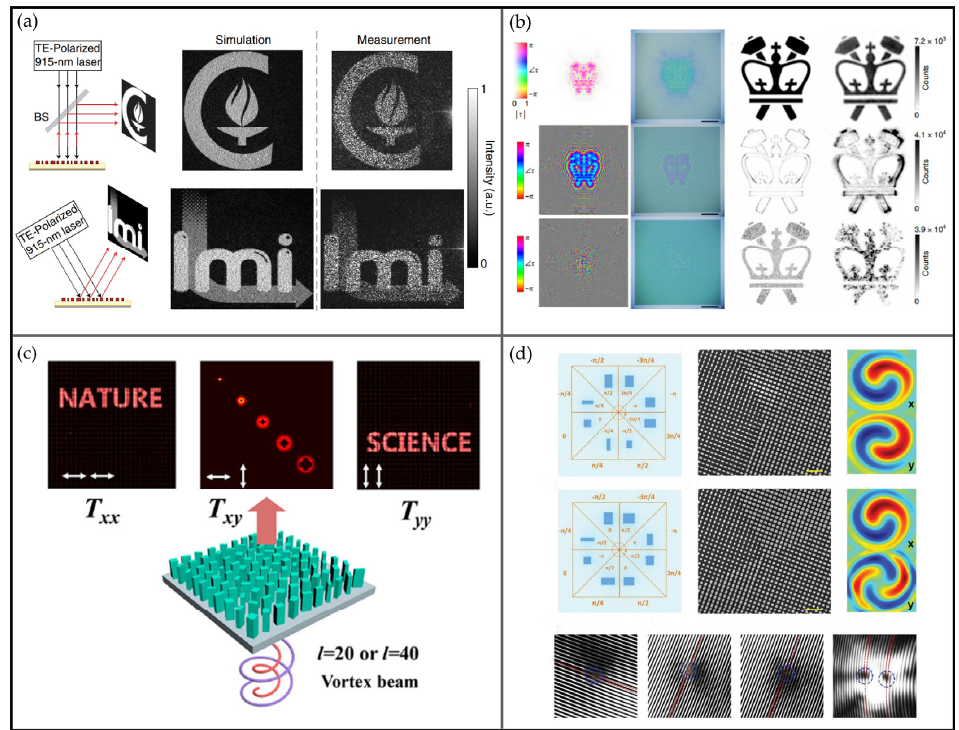
Figure 4. ( a ) The angle-multiplexed hologram exhibits different holograms under normal and 30° incident angles with TE polarization. Reprinted from [73]. CC BY 4.0; ( b ) Si metasurface realizes the multiplexing of amplitude and phase, shows holograms, and compares them with phase mod- ulation only, Reprinted from [74]. CC BY 4.0; ( c ) the OAM multiplexing at different polarization channels Si metasurface demonstrates several holographic encryption. Reprinted from [75]. Copy- right 2020 American Chemical Society; ( d ) the schematic diagram of Si polarization multiplexing metasurface achieves a vortex converter, which transforms a Gaussian beam into a vortex beam with helical wavefront and shows experimental results of different OAM and Gaussian beams interference. Reprinted from [76], Copyright 2022 Wiley-VCH GmbH. It is worth mentioning that, although the above-mentioned metasurfaces can achieve various types of multitasking, but the full dimensional control of light (i.e., the independ- ent, simultaneous, and complete control of phase, polarization, amplitude) has rarely been reported, we believe that designing such full modulation metasurfaces will be an im- portant and promising direction to explore the further potential of efficient and complete light–matter interactions. 5. Si-Based Tunable Metasurfaces Conventional metasurfaces are often not tunable: Their physical properties are fixed after fabrication. Such metasurfaces are usually inactive and unchangeable with time with limited functionalities. Therefore, it is highly desirable to develop tunable metasurfaces for post-fabrication with flexible tunability and functionalities. At present, there has been some related research conducted on tunable metasurfaces [77–84]. Here, we mainly sum- marize silicon-based tunable metasurfaces and introduce their properties. The current realization of tunability is mainly based on embedded tunable materials, including liquid crystals (LCs) [85,86], phase-change materials [87,88], etc., or other typical electroactive materials such as two-dimensional materials [82,89,90], III-V materials [78,91] etc. Afterward, the embedded structures can be used to control the properties of metasurfaces and exhibit tunable characteristics via mechanical tuning [80,92,93], electri- cal tuning [78,82,86,89–91], thermal tuning [94–96], and optical pumping [97–99]. One